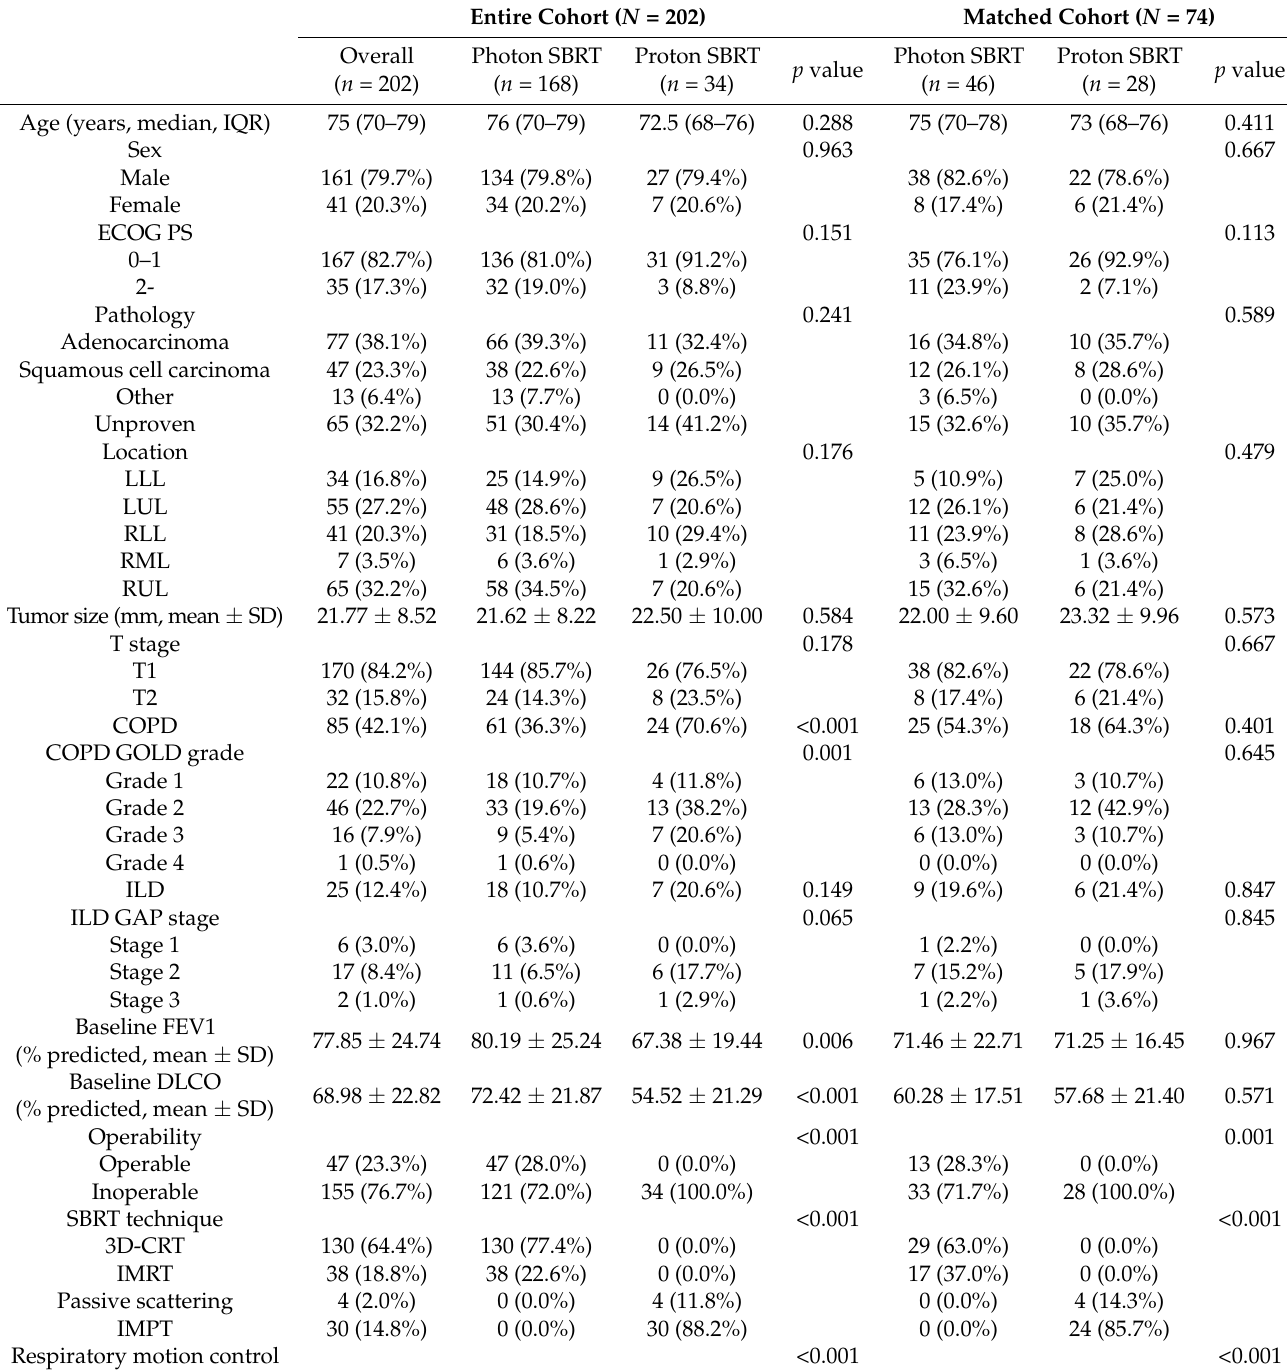
Table 1. Baseline clinical and treatment